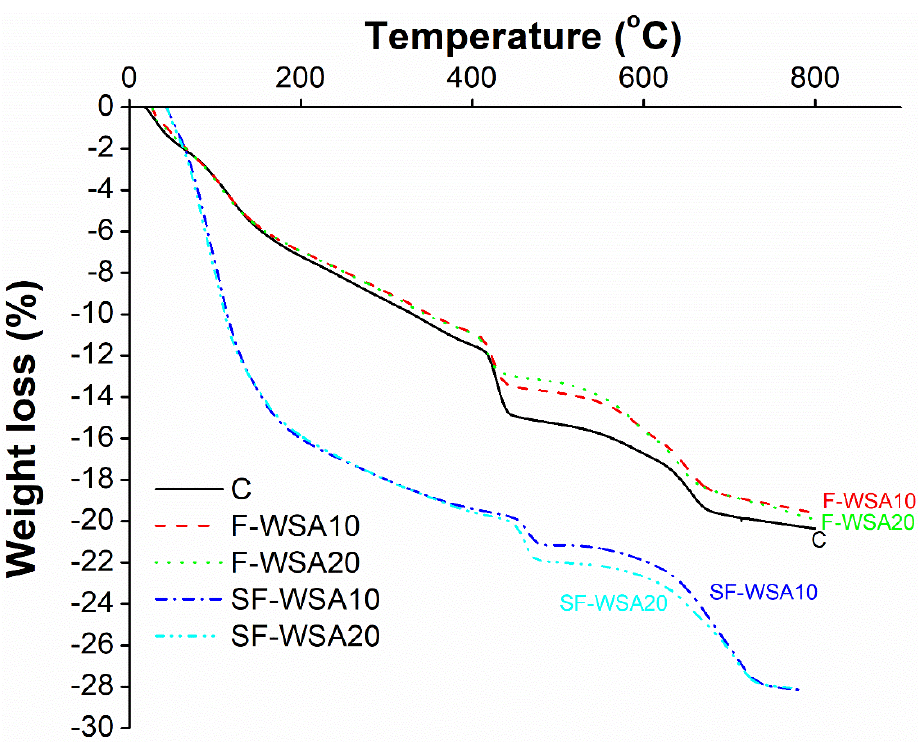
Figure 10. TGA results for control concrete (CC) paste and pastes containing different percentages of fine and superfine WSA at 28